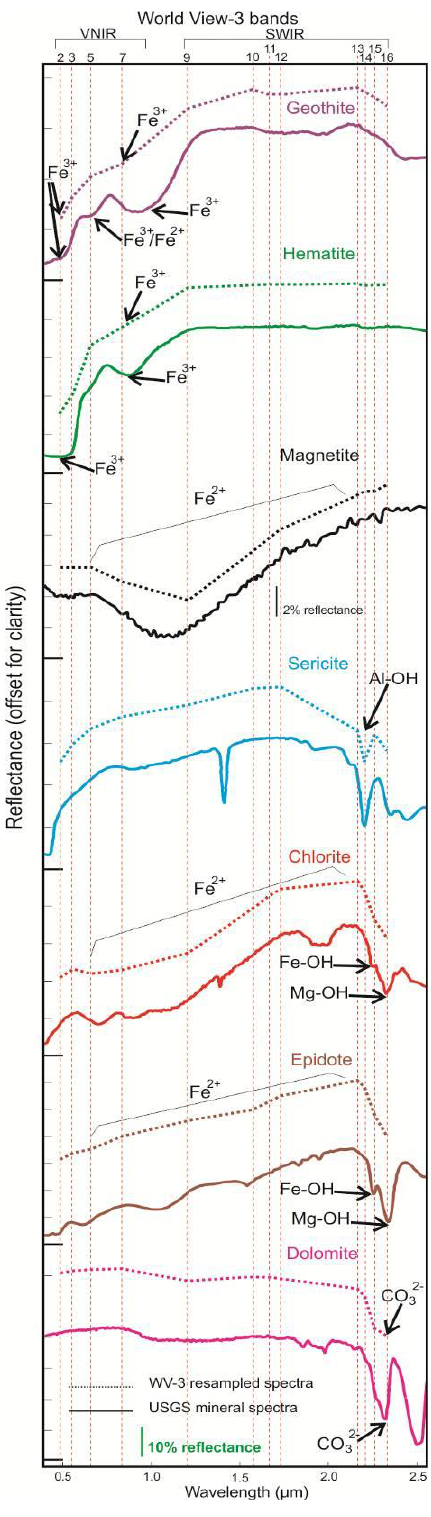
Fig. 3. Spectral pairs of USGS spectral library and WorldView- 3 (WV-3) resampled spectra. Dotted red lines show positions of WV-3 spectral band centers. Spectral absorption features for Fe 3+ , Fe 2+ , Al-OH, Fe-OH, Mg-OH and CO 32– are labeled. Spectra are offset on the vertical axis for clarity; scale showing 10% reflectance is regarded to all spectra except magnetite